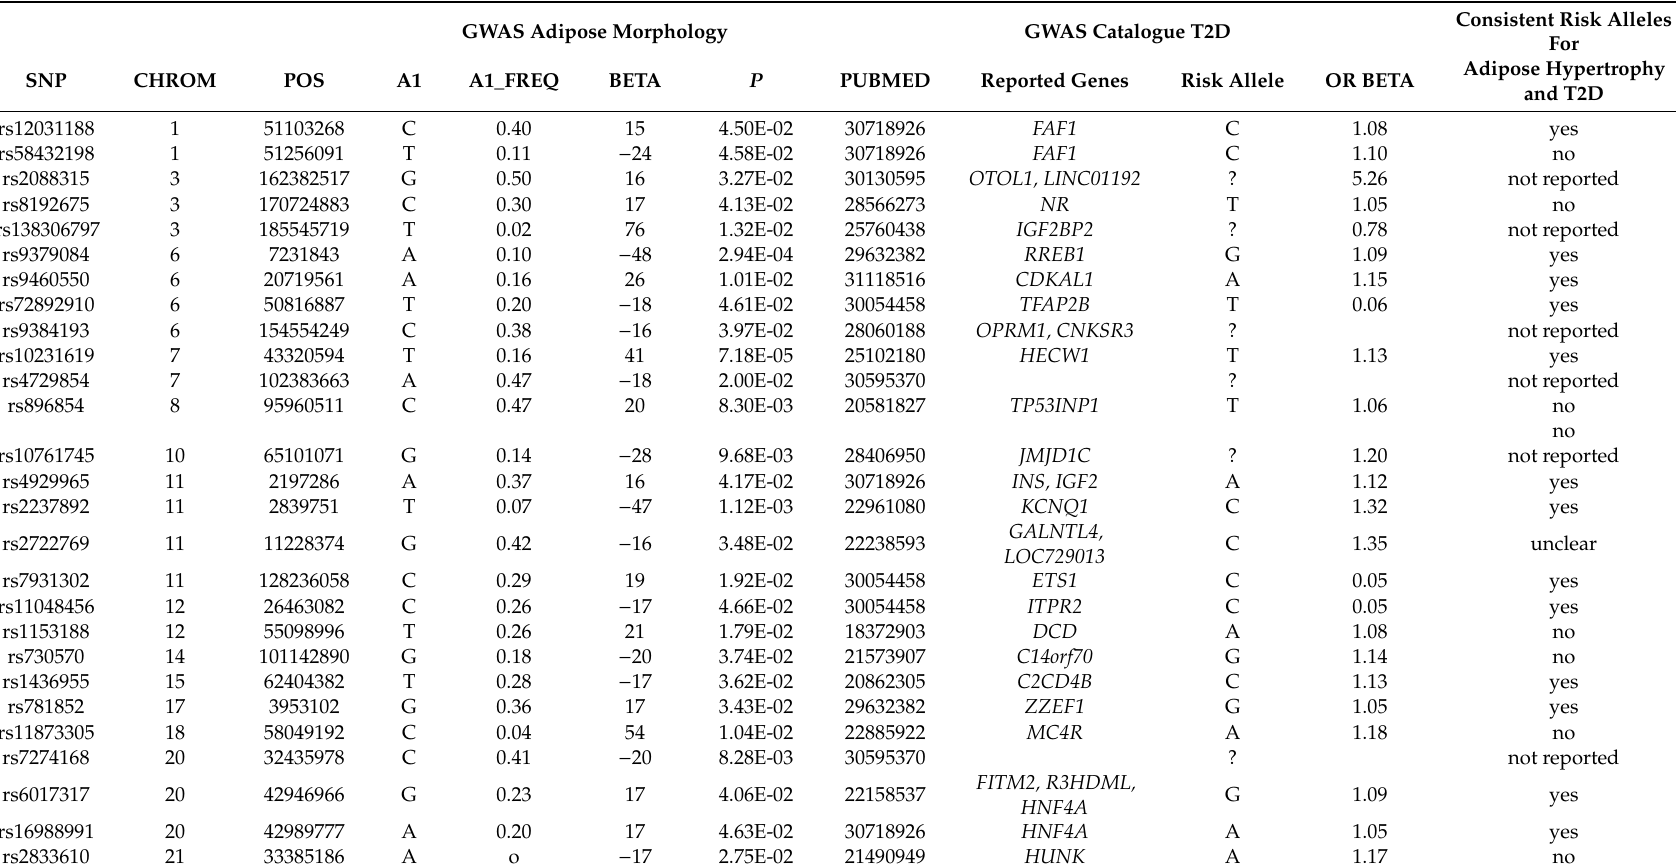
Table 3. Tag genome-wide association study (GWAS) SNPs associated with type 2 diabetes and with adipose morphology in the current